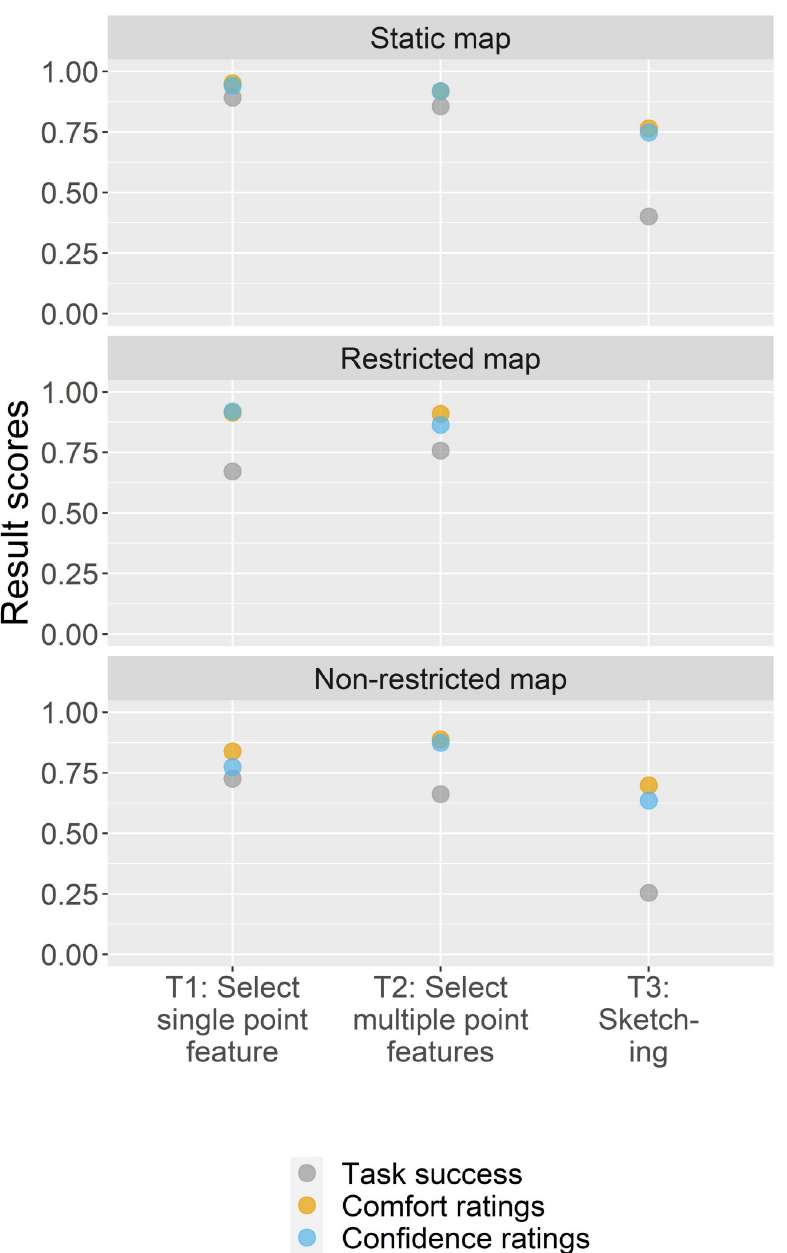
Fig 10. Task success, comfort, and confidence ratings of map design